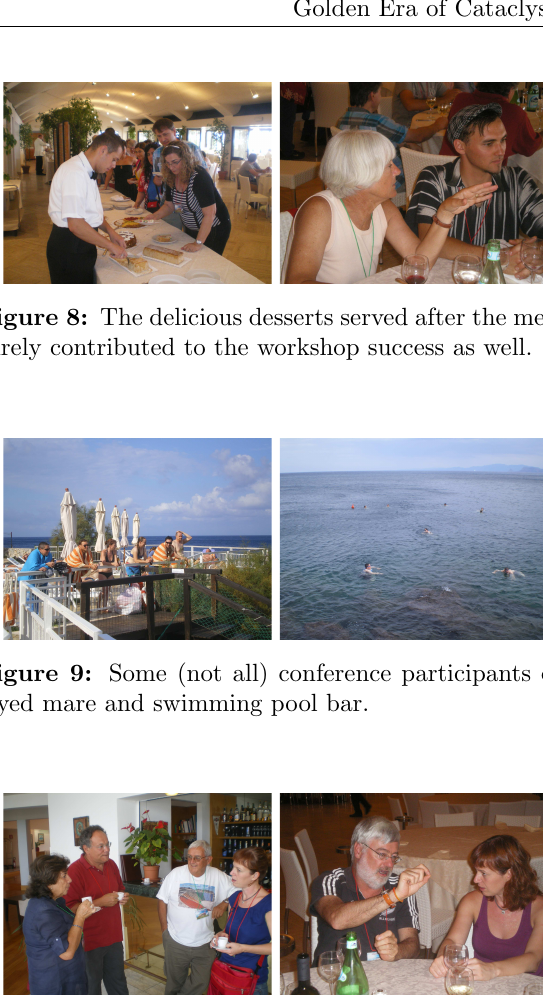
Figure 10: Sometimes the discussions continued either at hotel bar, or at dining.